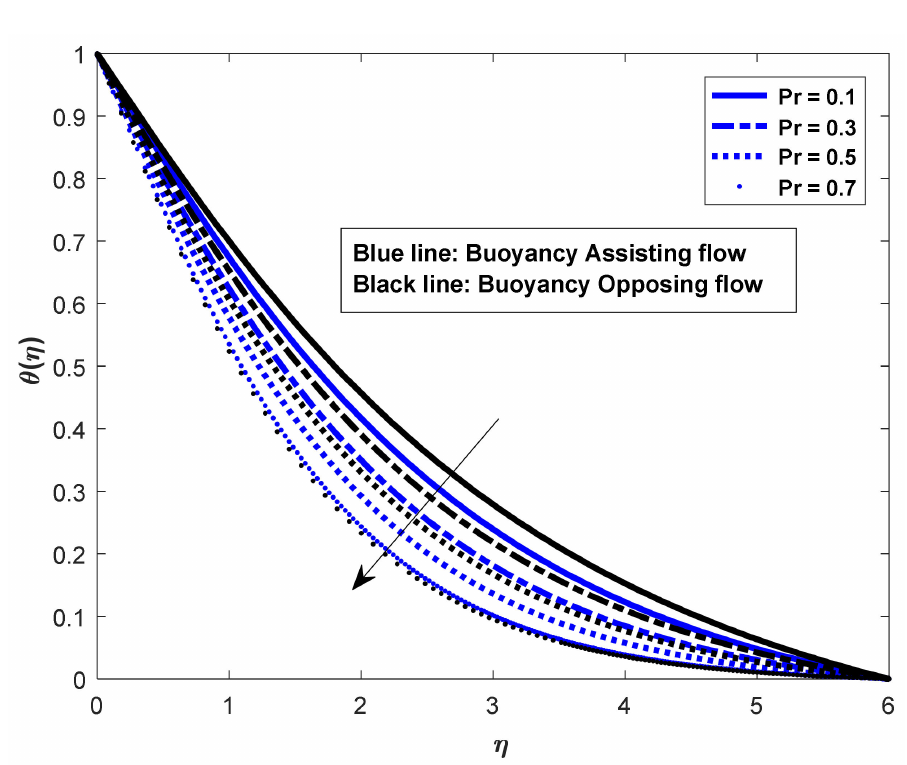
Figure 5. Pr on velocity.